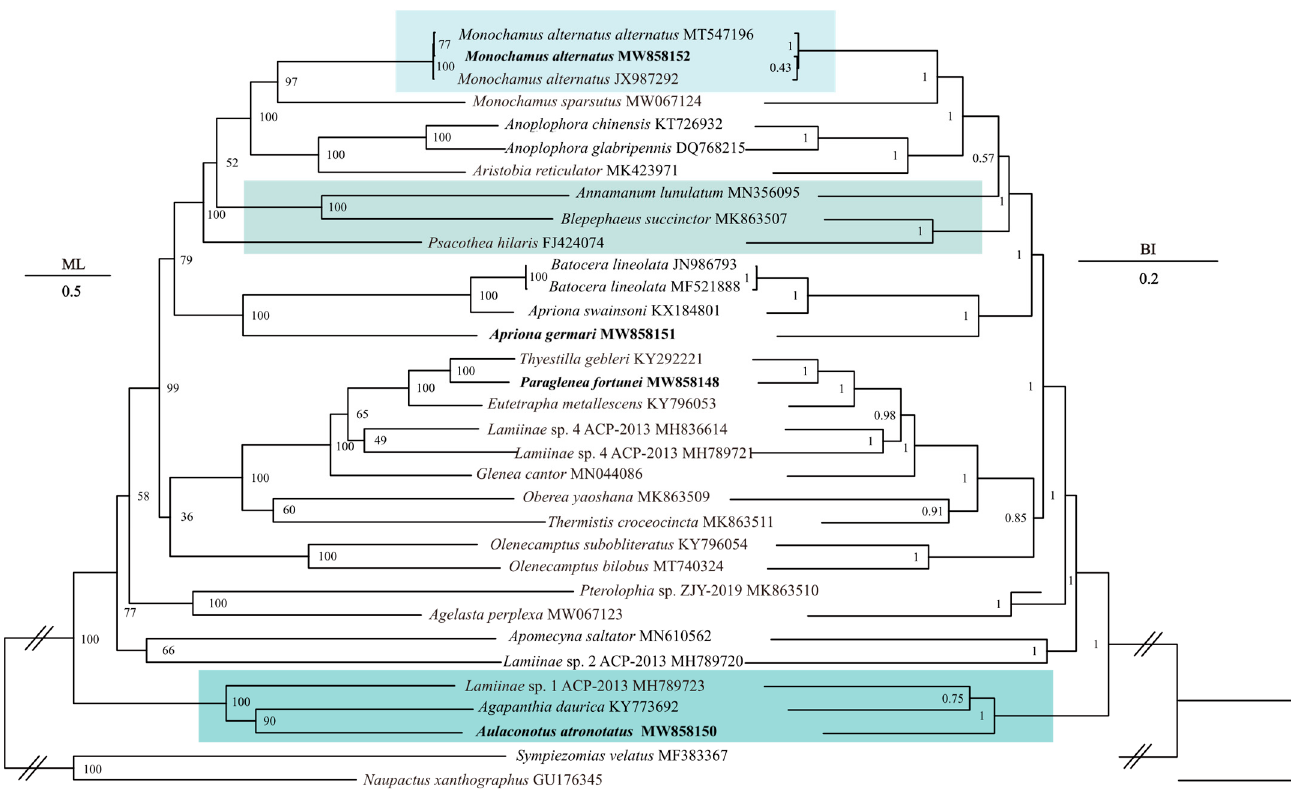
Figure 3. Phylogenetic tree of the relationships among 33 species of longicorn beetles based on the nucleotide dataset of the 13 mitochondrial PCGs. S. velatus and N. xanthographus was used as the outgroup. The numbers above branches specify posterior probabilities as determined from BI (left) and bootstrap percentages from ML (right). The GenBank accession numbers of all species are shown in the figure. The species in bold are sequenced in this study, and the species with colored frame are the species with different topology between ML and BI trees.